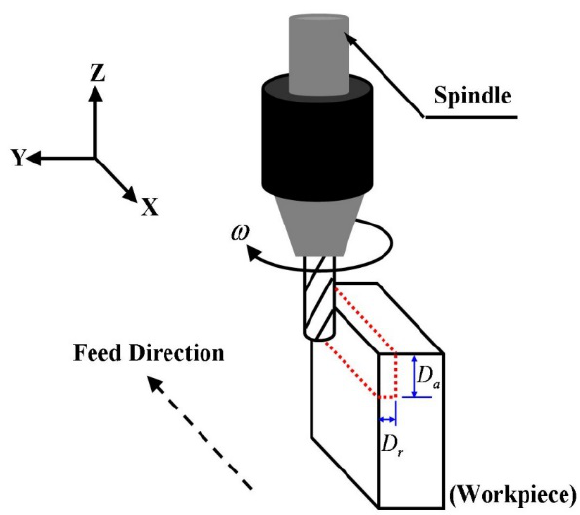
Figure 16. Cutting path of milling tests.